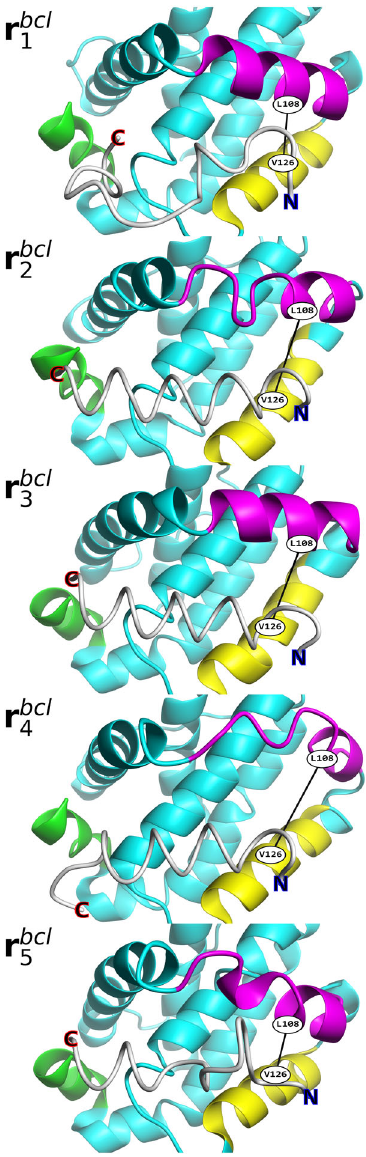
Fig. 5 Conformations of Bcl-xL in the presence of Bim as shown on the FEL in Fig. 4. Shown are the structures r bcl k of Bcl-xL in the presence of Bim (white). The α helices α 3, α 4 and α 8 of Bcl-xL are indicated in magenta, yellow and green, respectively, while the residues correspon d ing to d 1, L108 and V126, also indicated, with the values corresponding to this distance listed in Table S7. Also indicated are the location of the N- and C-termini of